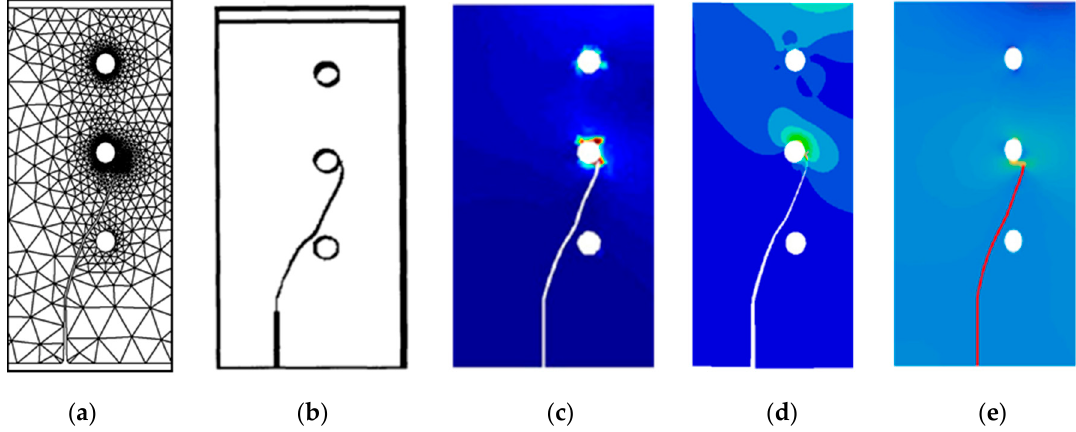
Figure 9. Final crack growth path for case I: ( a ) present study, ( b ) experimental results [32], ( c ) [33] with permission of Elsevier 2019, ( d ) [34] with permission of Elsevier 2018, and ( e ) [35] with permission of Elsevier 2020.